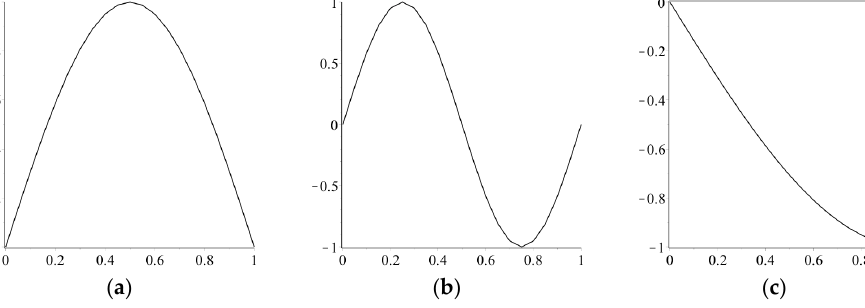
Figure 4. FGM1 beams’ vibration modes: ( a ) first mode, ( b ) second mode, ( c ) third mode. L/h = 10.